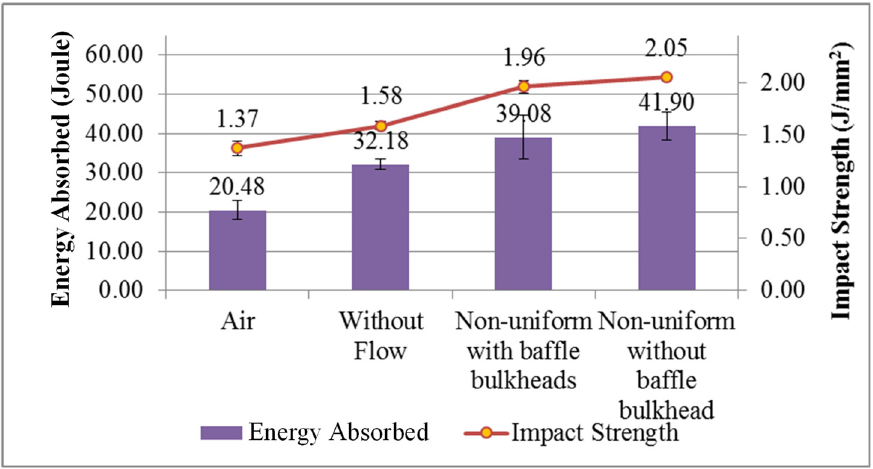
Figure 9. Graphical summary of the impact test results.